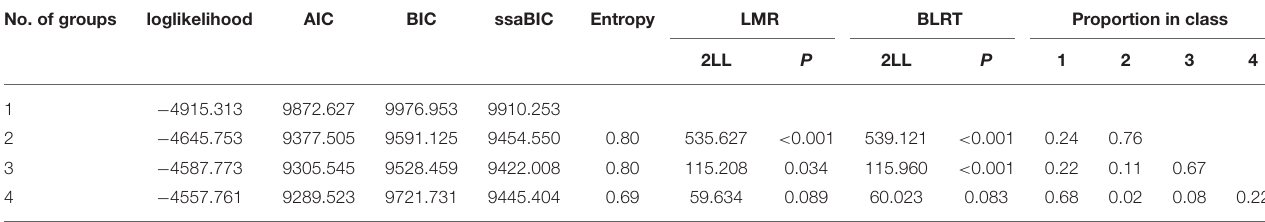
TABLE 2 | Comparing models with different latent classes: fit indices (no. of Obs = 1,582). No. of groups